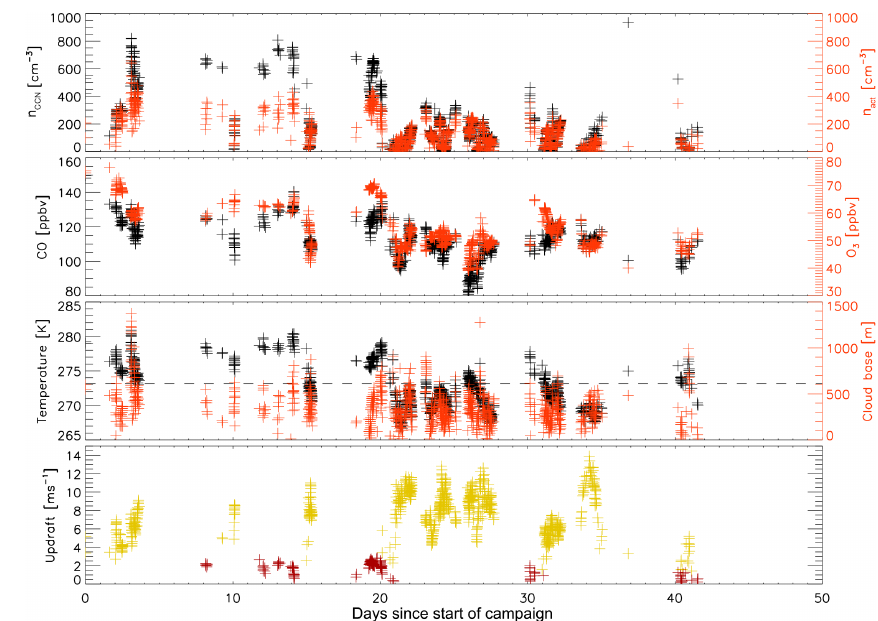
Figure 2. As for Fig. 1 but for CLACE2010. Note that the axis ranges differ from those in Fig. 1.